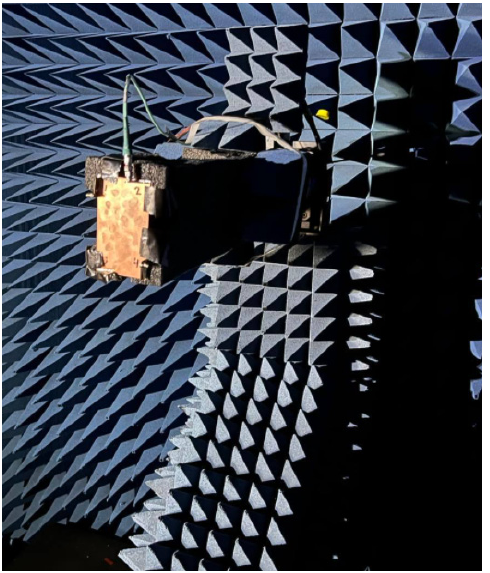
Figure 5. The proposed MIMO antenna design installed inside an anechoic chamber in the antenna measurement lab. The simulated S-parameter curves for Ant. 1, Ant. 2, Ant. 3, and Ant. 4 are shown in Figure 6a, while the measured S-parameter curves for Ant. 1, Ant. 2, Ant. 3, and Ant. 4 are